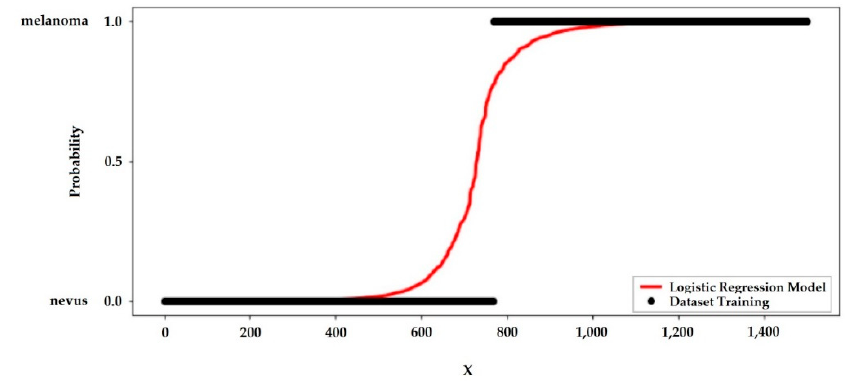
Figure 7. Logistic Regression Model of the Proposed Strategy.